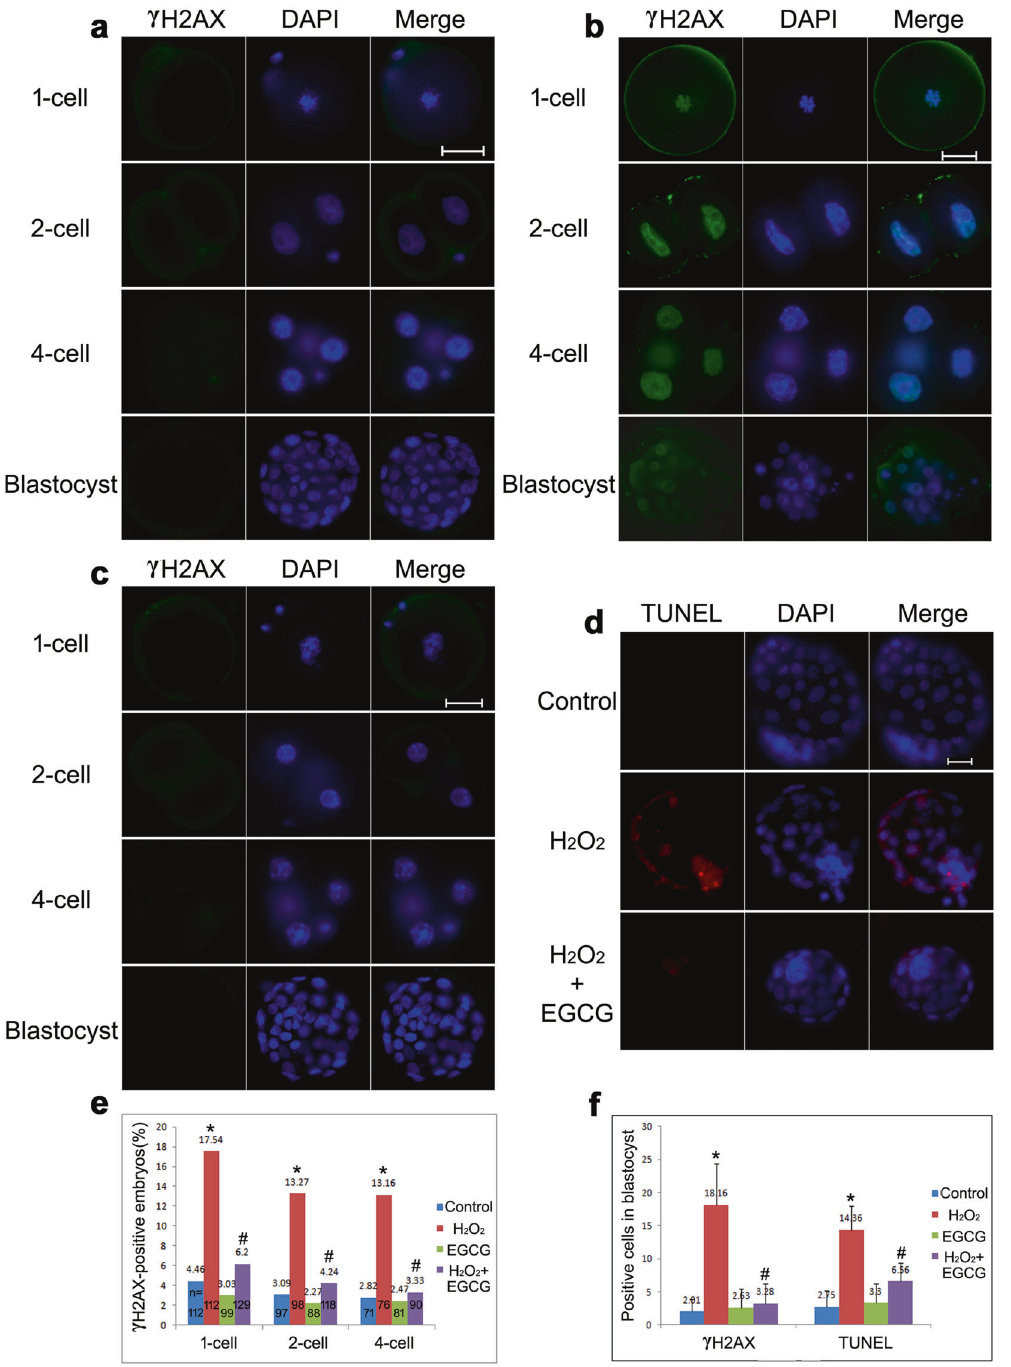
Fig. 3 DNA damage in IVF embryos. a – c Representative fl uorescence micrographs of γ H2AX (green) in the control, H 2 O 2 -treated, and H 2 O 2 / EGCG-treated groups. d Representative fl uorescence micrographs of TUNEL-positive apoptotic cells (red) in blastocysts. Nuclei are stained with DAPI (blue). Scale bar, 20 μ m. e Rates of γ H2AX-positive embryos at the 1-cell, 2-cell, and 4-cell stages. Data are shown as percentages collected from at least three independent experiments, and n shows the total number of embryos. Differences among groups were analyzed using Pearson ’ s χ 2 test. * P < 0.05 vs. control, # P < 0.05 vs. H 2 O 2 treatment. f Rates of γ H2AX- and TUNEL-positive cells in blastocysts. Data are expressed as the means ± SDs, collected from three independent experiments, and each experiment had at least fi ve embryos. Differences among groups were analyzed using Student ’ s t test. * P < 0.05 vs. control, # P < 0.05 vs. H 2 O 2